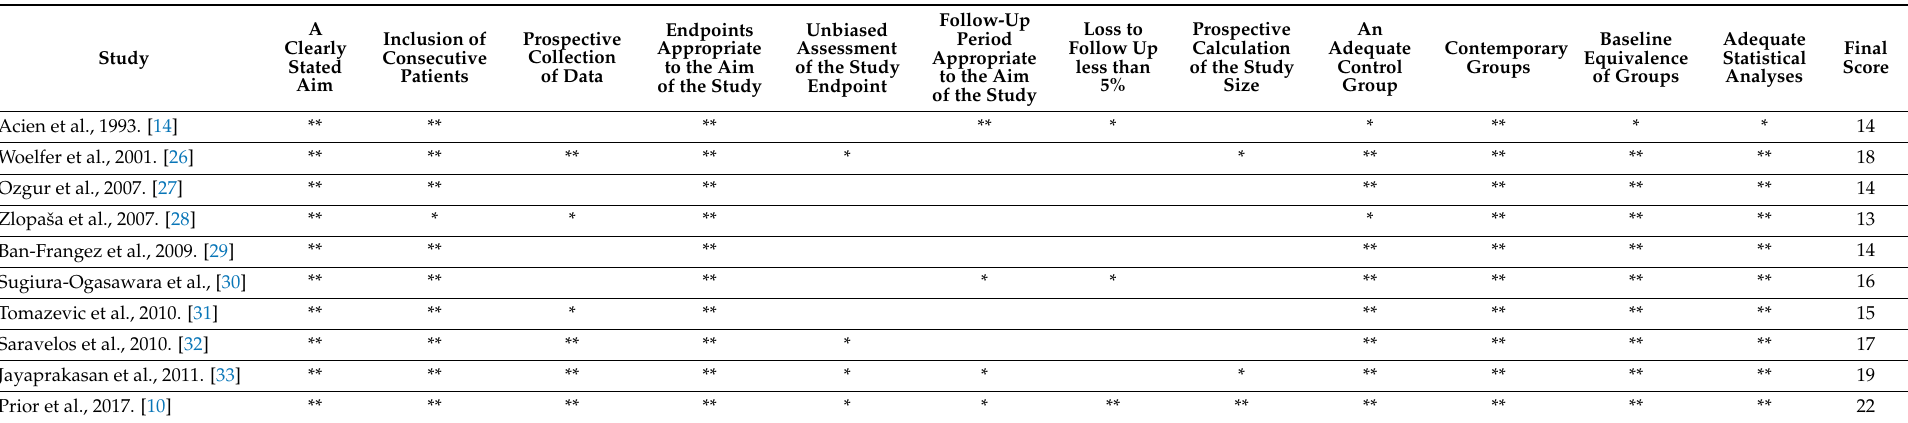
Table 4. Uterine septum versus controls (no septum)—comparative studies.